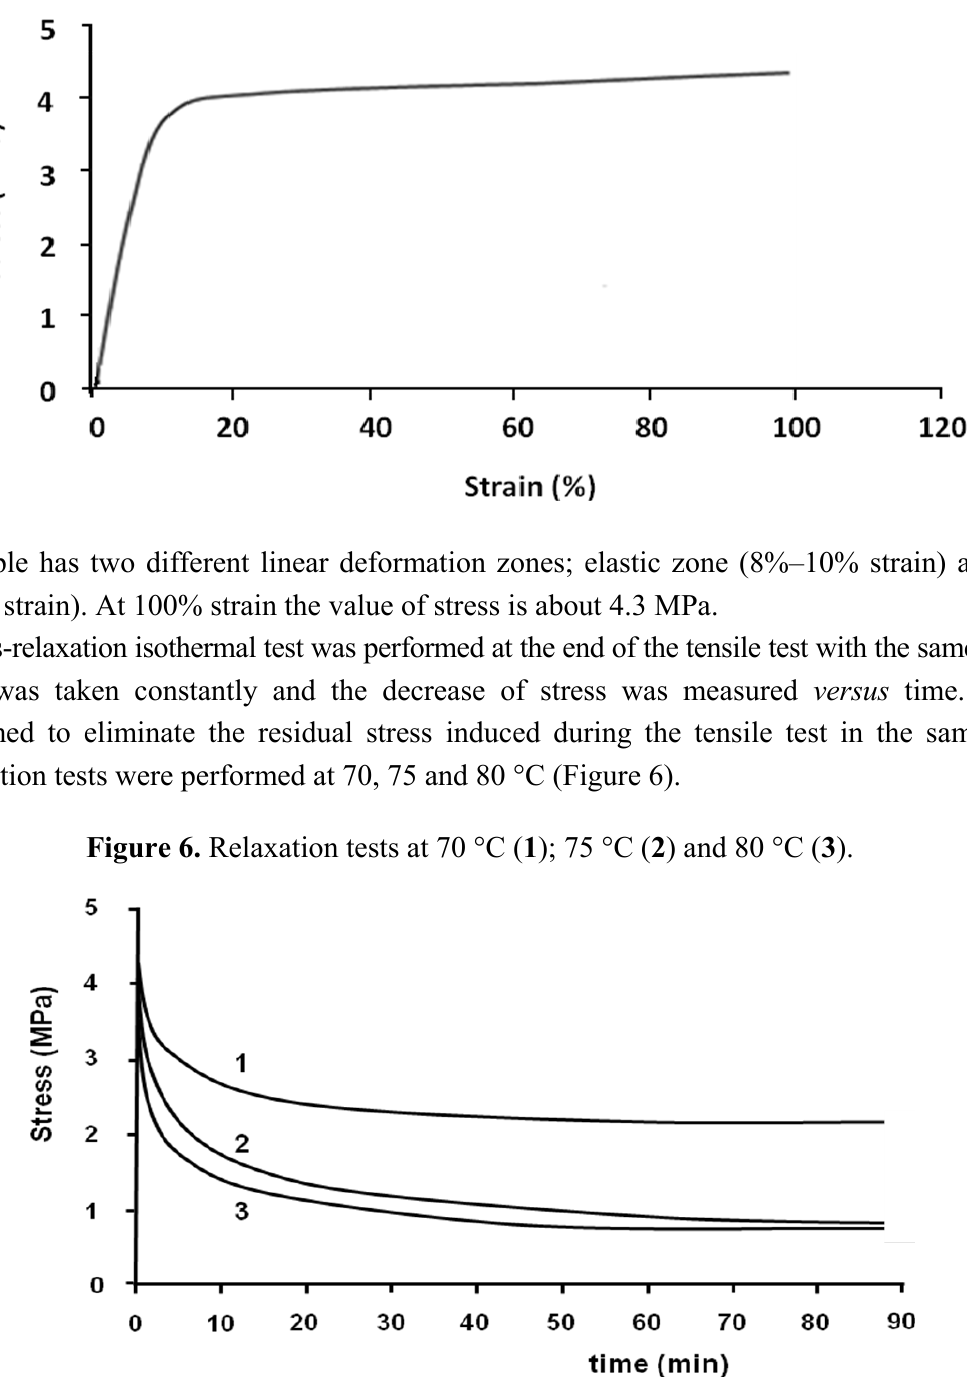
Figure 5. Nominal stress–strain curves of parallel sample at 70